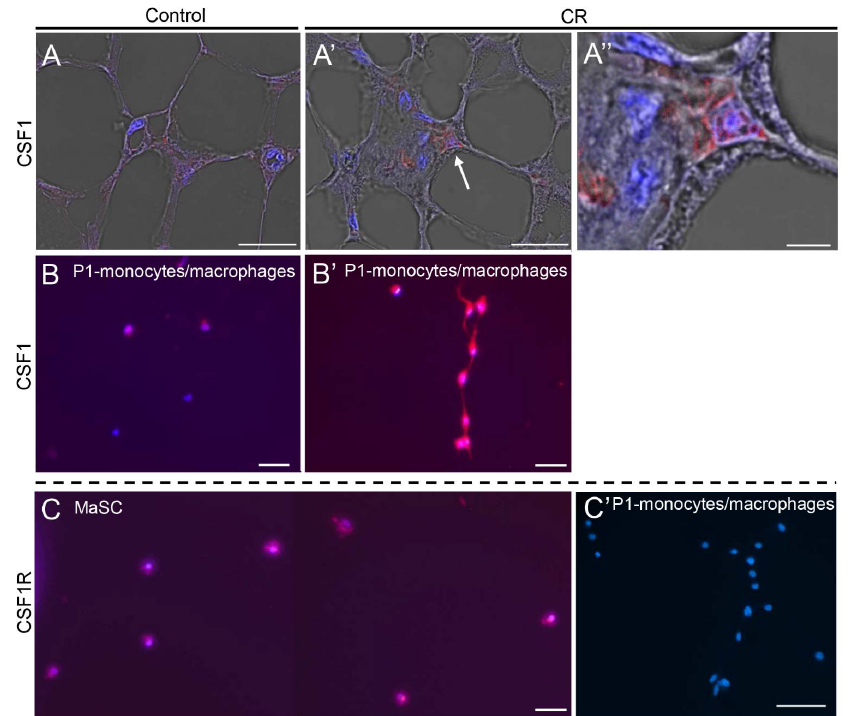
Figure 6. Immunofluorescence analysis demonstrating the inductive effect of calorie restriction (CR) on CSF1 expression in the mammary gland. ( A – A’’ ) CR induces CSF1 expression in the mammary ducts. Arrow indicates CSF1-expressing cell. ( B , B’ ). CR-induced CSF1 expression in P1 (Figure 4A) monocytes/macrophages cultured for 4 days. ( C,C’ ) CSF1R is highly expressed in mammary epithe- lial stem cells (MaSCs) after attachment but is not detected in monocytes/macrophages of the P1 fraction. Bar = 50 μm.